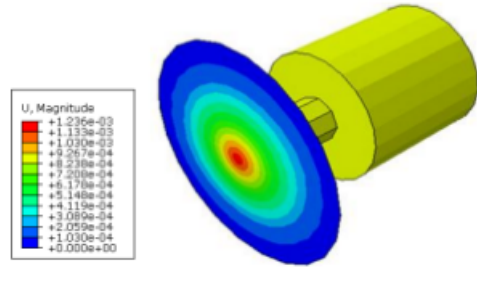
Figure 15: Results from simulation of a typical 8-ply